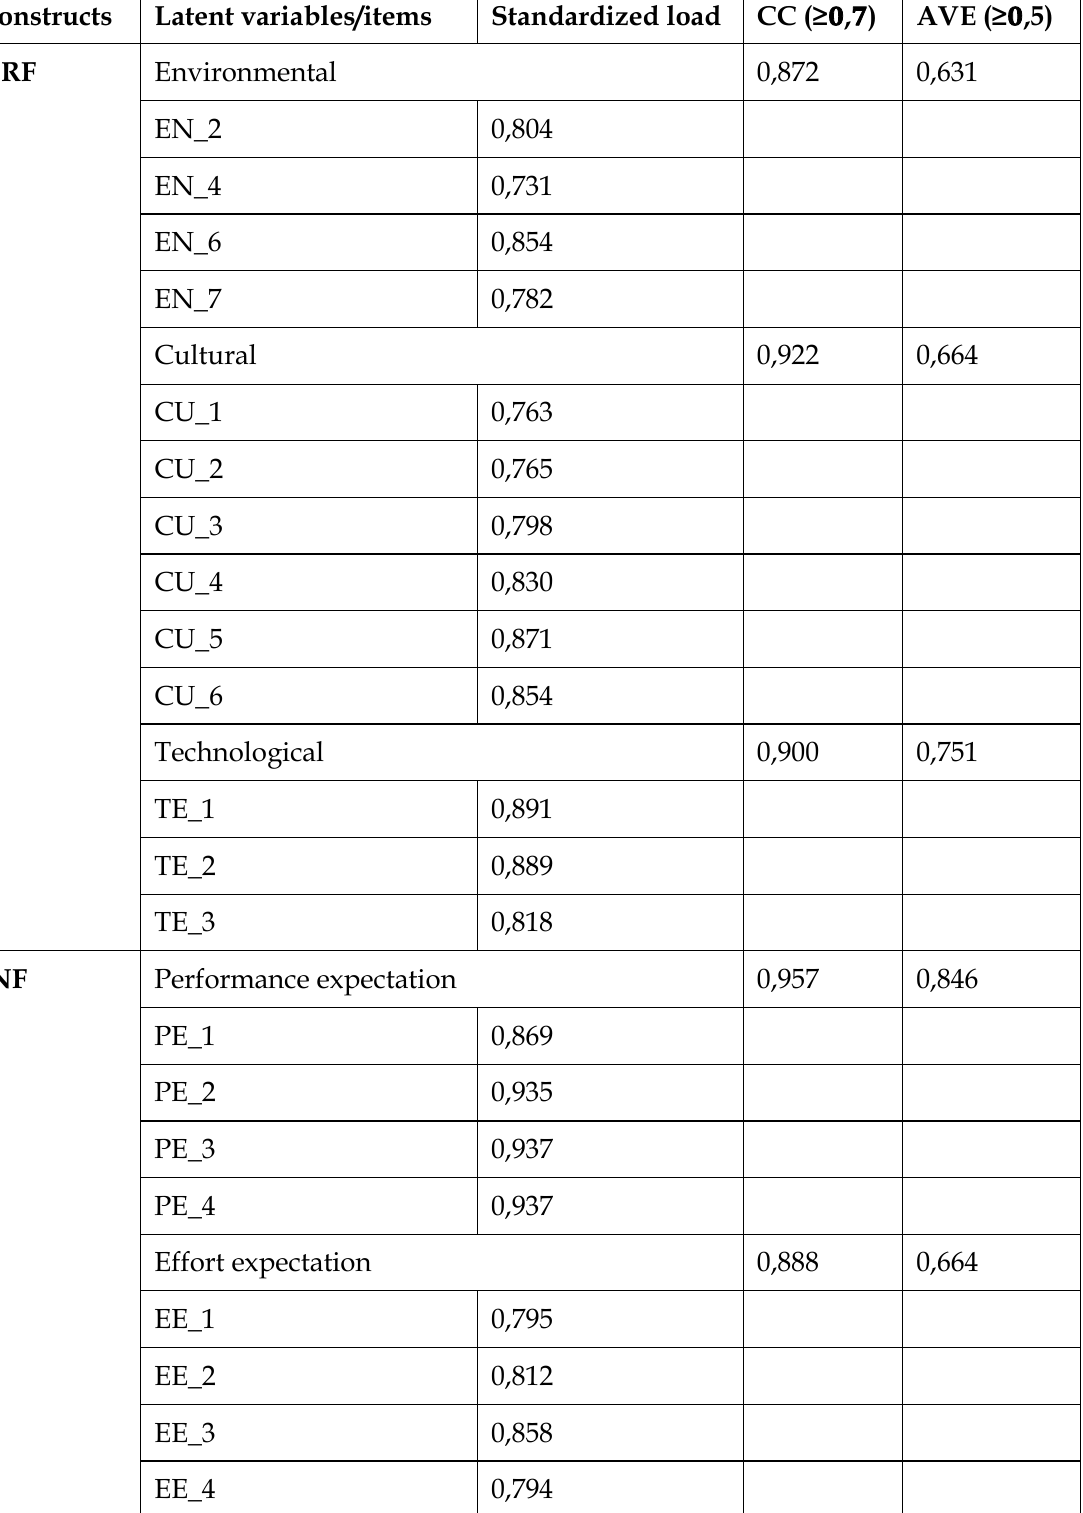
Table 5: Convergent validity